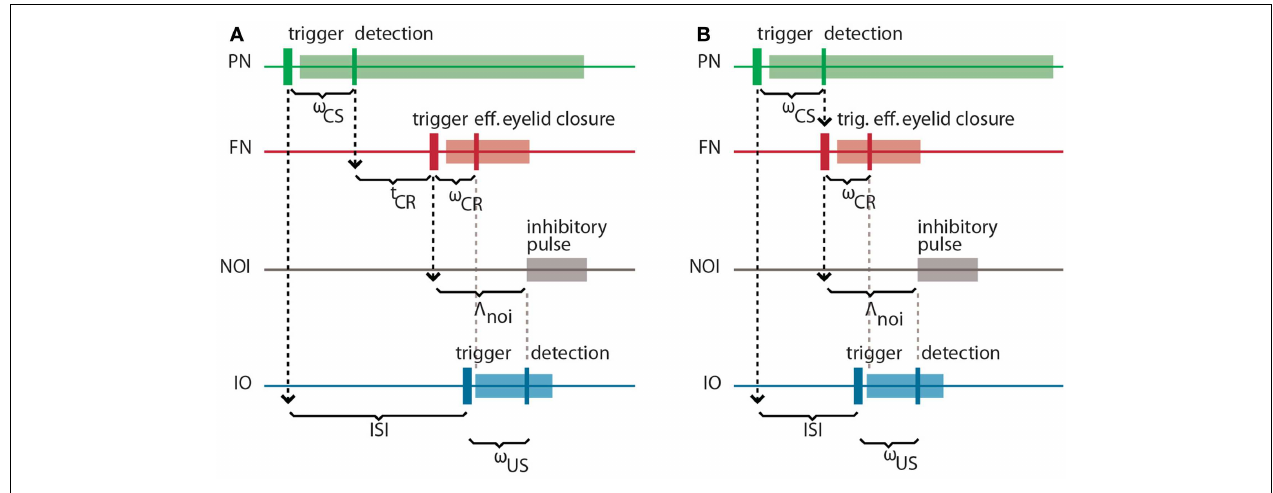
neuronal triggering of the CR and the effective eyelid closure, (cid:51) noi , delay between the CR trigger and the onset of the negative feedback loop inhibition; ω US , latency between the US-trigger and the detection of its associated neural response in the IO. (B) Same latencies as in (A) for the minimum learnable